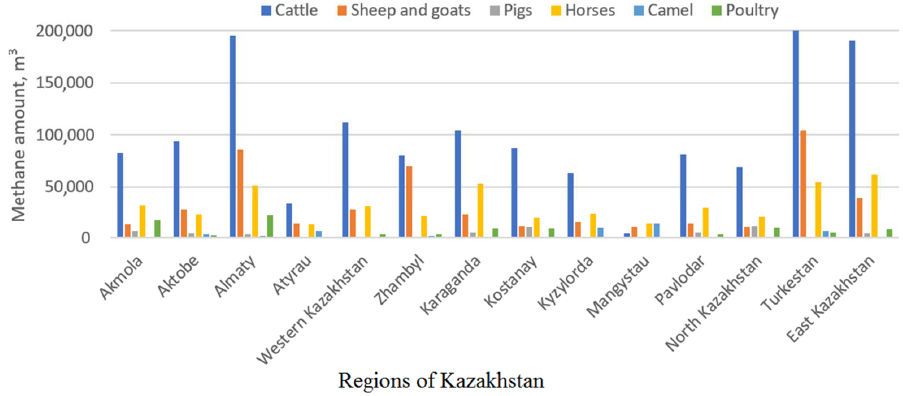
Figure 5. Amount of methane production in Kazakhstan in 2019.